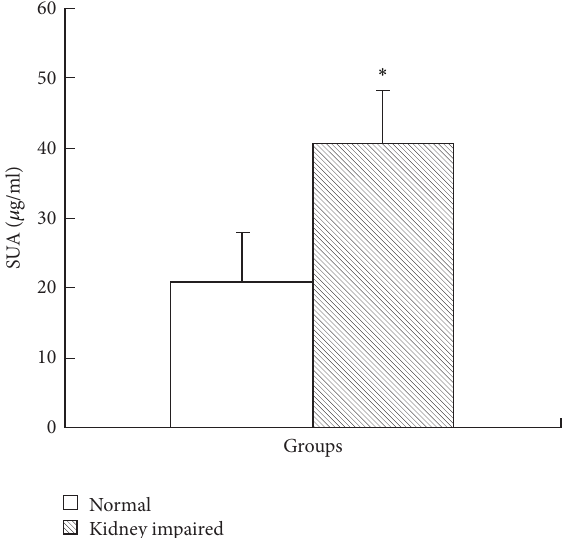
Figure 4: Uric acid in serum in kidney impaired group increased to a higher level (mean ± SD, 𝑛 = 10 ). The concentration of uric acid in kidney impaired group was 40.77 ± 7.52 𝜇 g/mL ( 242.5 ± 44.73 𝜇 M), much higher than that in normal rat serum ( 21.93 ± 6.98 𝜇 g/mL ( 124.5 ± 41 .5 𝜇 M), 𝑃 < 0.05 ). Rats in kidney impaired group were intragastrically treated with adenine (400mg/kg × 5 days), while those in normal group were treated with normal saline of the same volume. ∗ versus normal group, 𝑃 < 0.05 , Student’s 𝑡